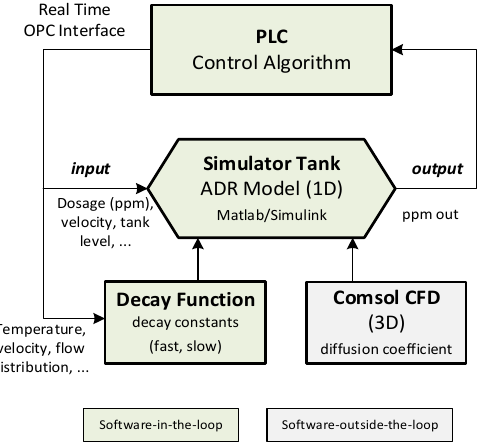
Figure 2. General architecture of the simulation system for tank chlorination.